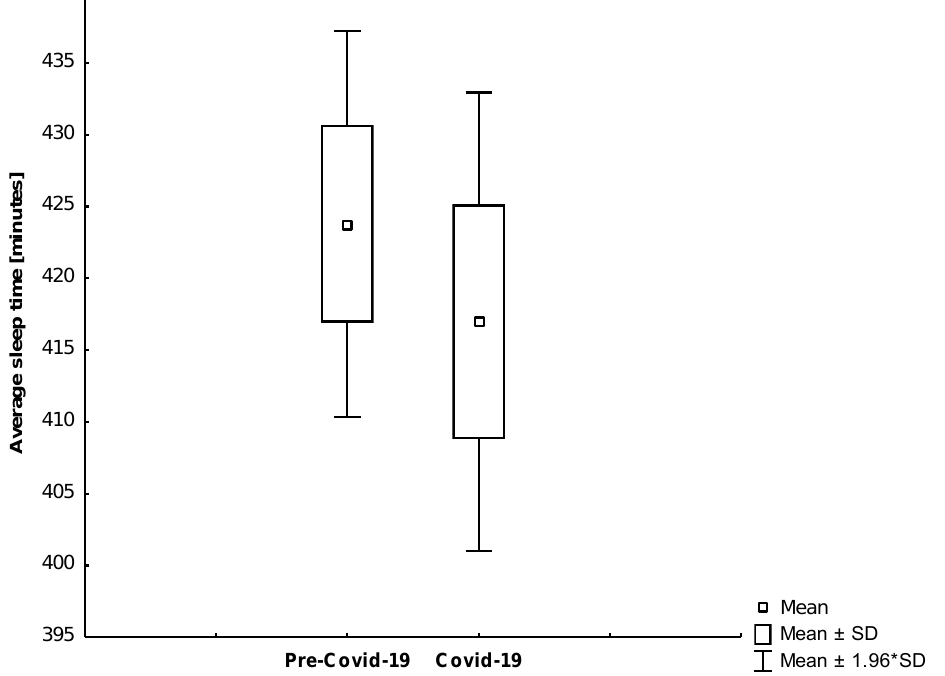
Figure 10. A comparison of the average sleep time between reference and self-isolation for all study participants ( p = 0.499).